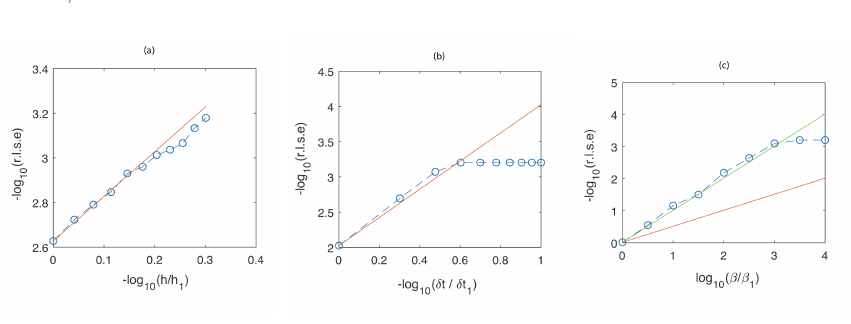
Figure 2. Comparing between the theoretical prediction (red curves) and numerical errors (blue curves). The numerical errors for the unit square are shown in Figure 2 in three parts each showing the effect of one parameter, h, δt, or β on the r.l.s.e using log-log plot. The red charts in each part of the Figure demonstrate the predictions of the error via the theoretical results, and the blue curves denote the error based on the observed numerical results. Figure 2 a indicates the graph of the r.l.s.e against the ratio of the spatial parameter h over the initial value h 1 while Figure 2 b and c , respectively, show the error values with respect to the time and the auxiliary parameter β with the initial values δt 1 and β 1 . Also, Figure 2 a and b show that the numerical results are in a good agreement with the theoretical conclusion. In Figure 2 a , the r.l.s.e is plotted against the spatial parameter h/h 1 with constant values of the other parameters β = 10 6 , δt = 0 . 01 and the same plot is shown in Figure 2 b for the time parameter δt/δt 1 with the parameter values β = 10 6 , h = 1 . Also in Figure 2 c δt = 0 . 01 , h = 1 . As is 40 40 observed, by decreasing the parameters h and δt the accuracy is increased which confirms the theoretical results. But in the implementation of our method, the condition numbers of the stiff and mass matrices are growing up as h is declining and this causes serious computational challenges for spatial discretization ( see [17,18]). Since the closeness of the time trial points leads to the correlated basis functions of the produced RKHS method, the practical use of this method increases the error of calculating the Gram-Smith coefficients. Figure 2 c shows the relationship between the auxiliary parameter β and r.l.s.e. We observe that the convergence rate is faster than the theoretical prediction. The green curve is a linear regression curve made by the r.l.s.e values excluding the last two error values which are farther from the others. This curve shows that the computational results may be more accurate than that of the